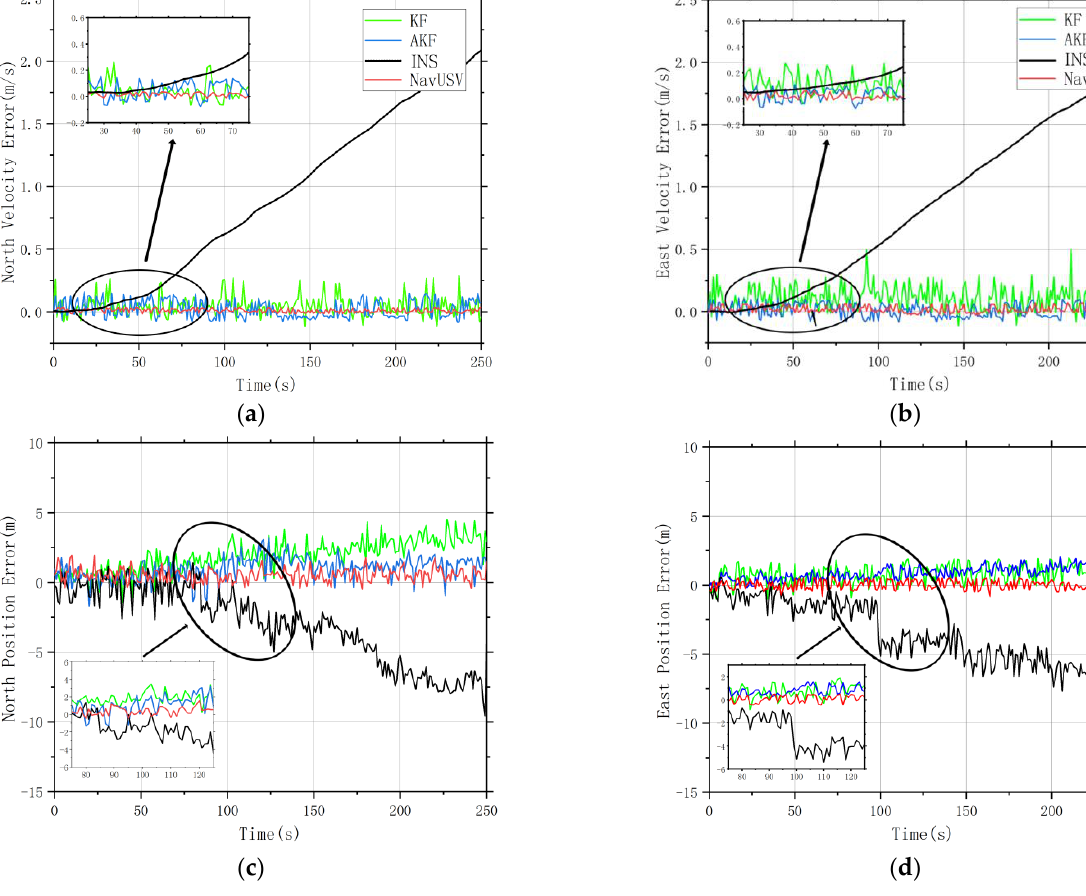
Figure 10. Position error and velocity error under different fusion algorithms: ( a ) North Velocity Error; ( b ) East Velocity Error; ( c ) North Position Error; ( d ) East Position Error.